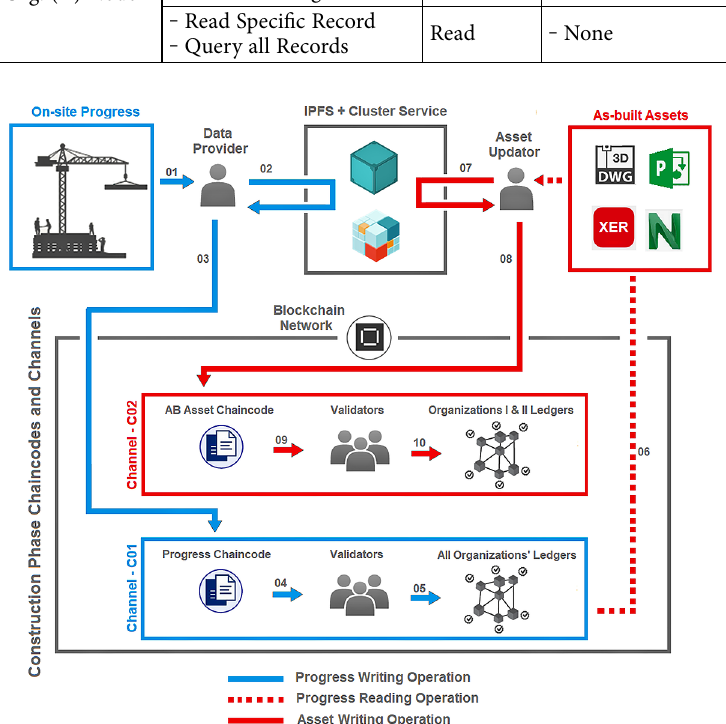
Figure 4. Processing of the progress